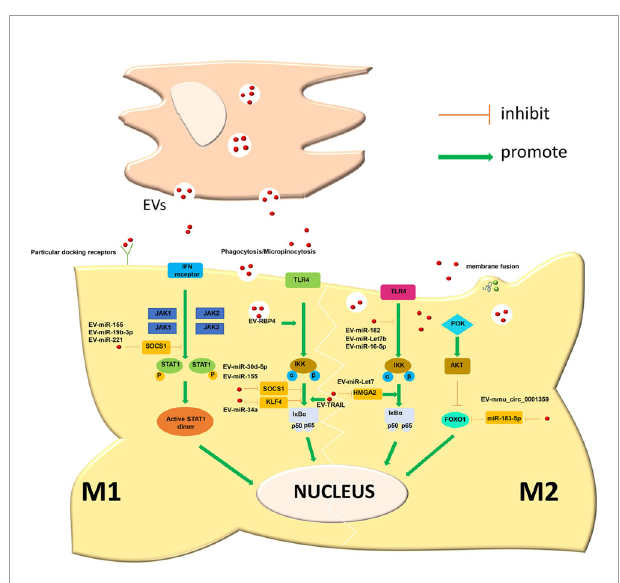
FIGURE 2 | Secretory cells release EVs to induce macrophage polarization through a variety of